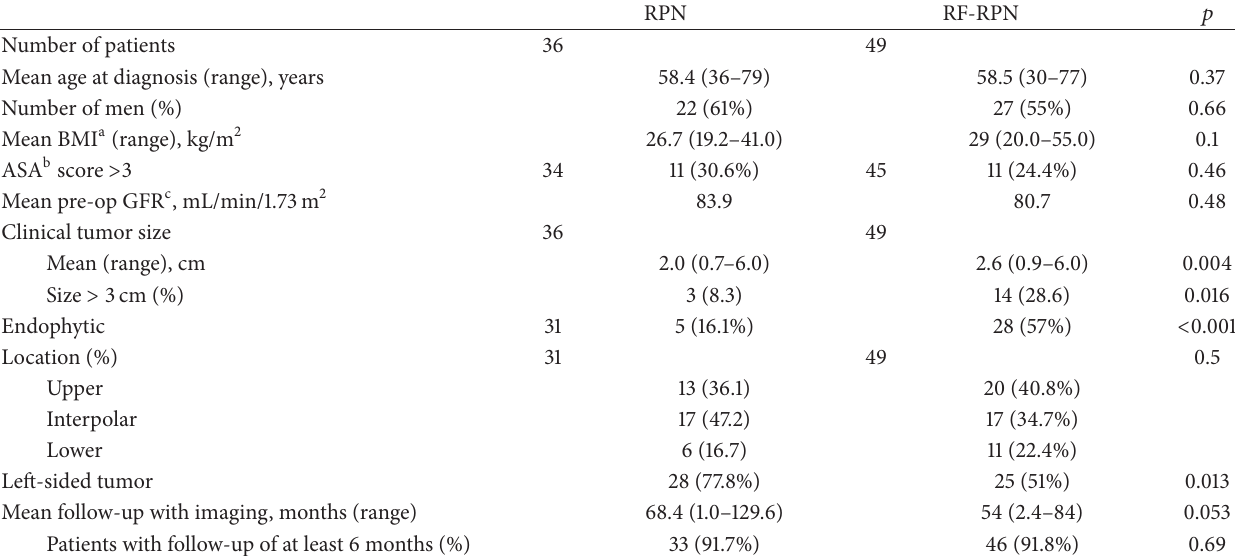
Table 1: Patient and tumor characteristics.